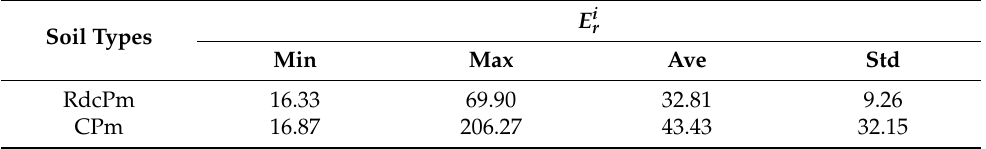
Table 4. Potential ecological risk index ( E i r ) of surface soil Cd in the study area. Soil